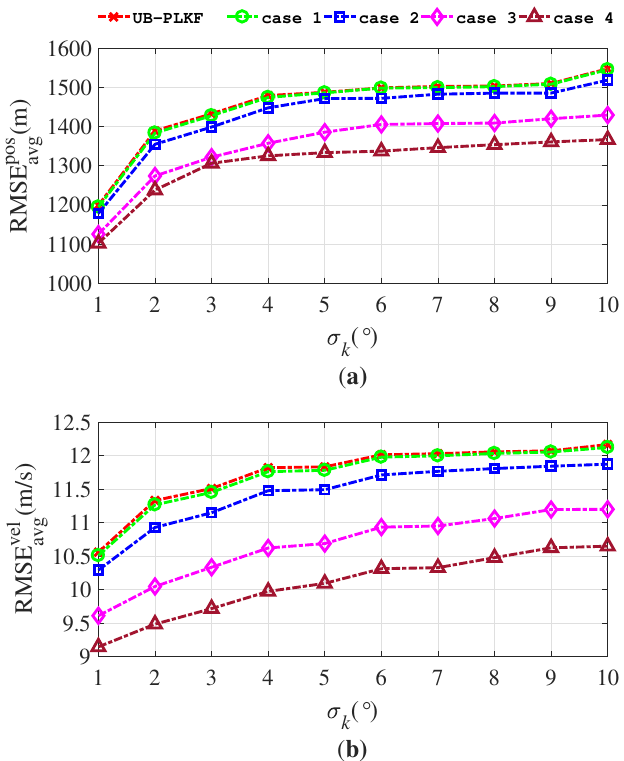
Figure 8. Time-averaged RMSEs for 4 cases of VC–PLKF in Table 1: ( a ) Time-averaged RMSEs for position; ( b ) Time-averaged RMSEs for